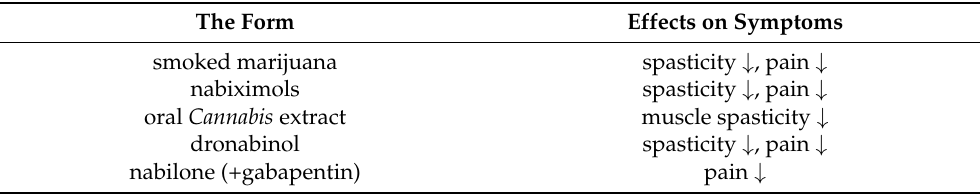
Table 5. Cannabinoid therapies and their impacts on the symptoms of multiple sclerosis determined in clinical trials [109]. ↓ : decrease. The